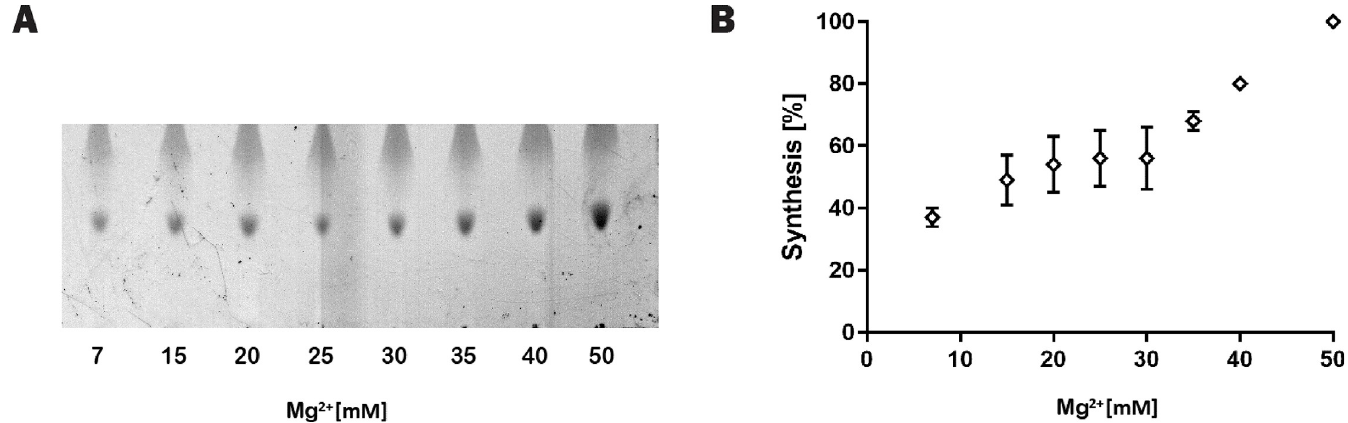
Fig 6. Effect of Mg 2+ on Lipid II synthesis with SMA-MraY. (A) A representative TLC plate showing synthesized Lipid II (after 2 h incubation) spots with increasing amount of Mg 2+ ; (B) Intensity of the Lipid II spots on TLC (n = 3) quantified by Image J and plotted against the concentration of Mg 2+ . Lipid II synthesis with 50 mM Mg 2+ present was set as 100%